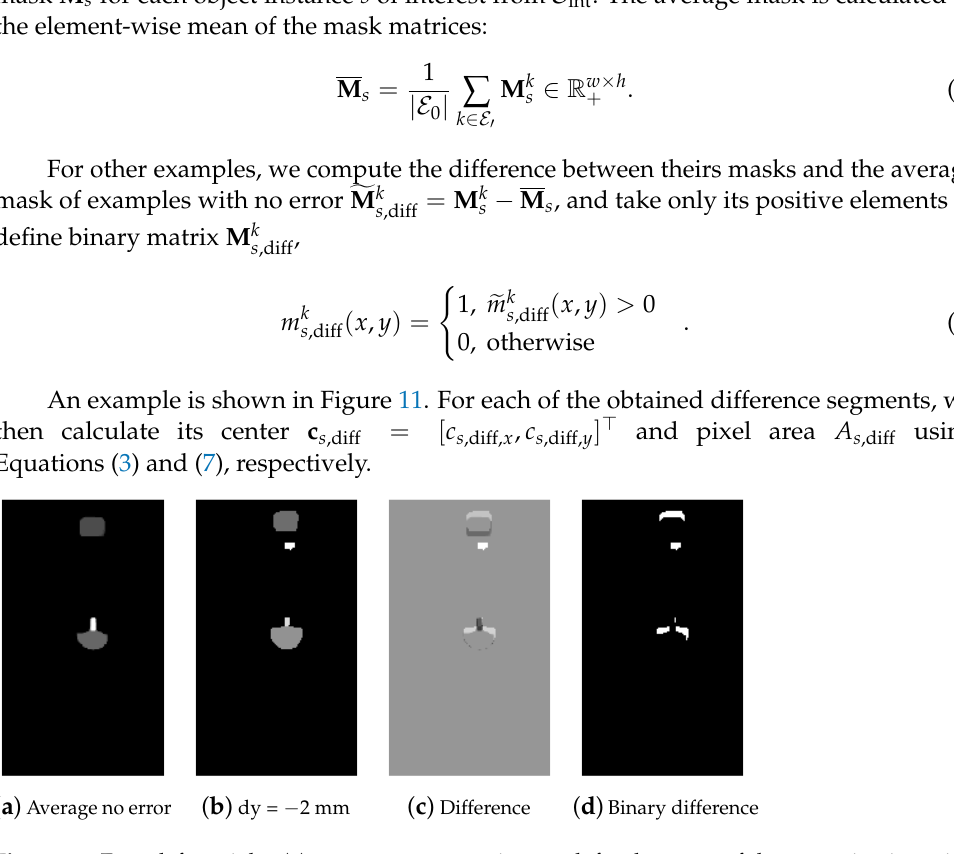
Figure 11. From left to right: ( a ) average segmentation mask for the successful copper ring insertion attempts, ( b ) segmentation mask for a failed insertion attempt (positional error in the y -direction), ( c ) difference of the segmentation masks, and ( d ) positive part of the